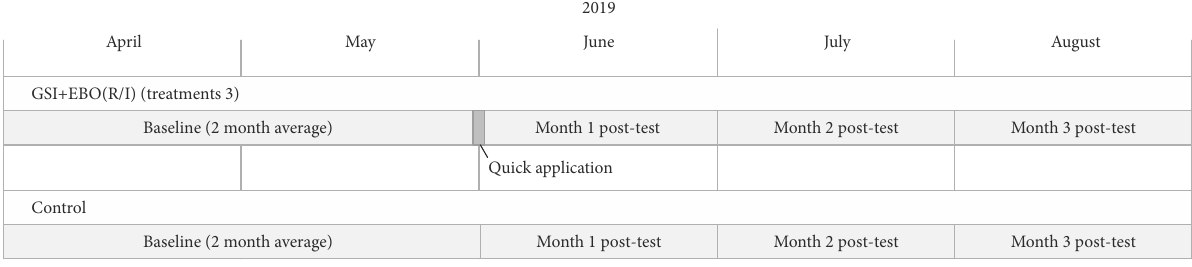
Figure 7. Intervention procedures for Case Study 2